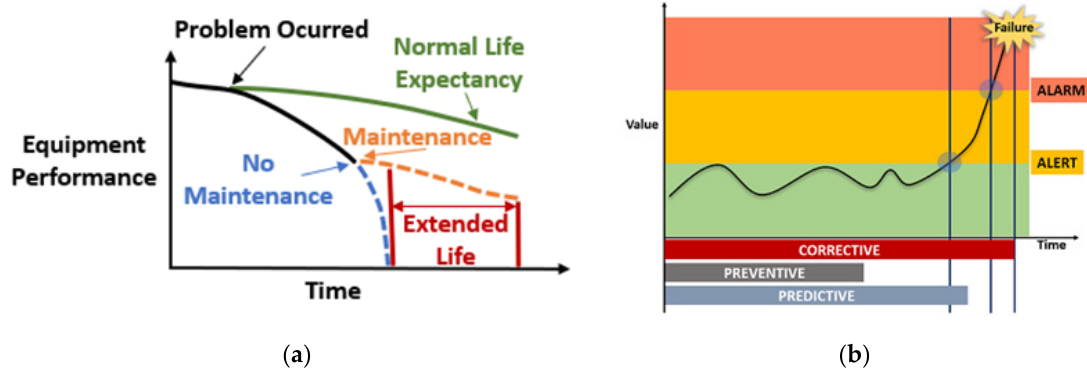
Figure 3. Factory maintenance: ( a ) Predictive maintenance (example); ( b ) Condition-based maintenance (example).